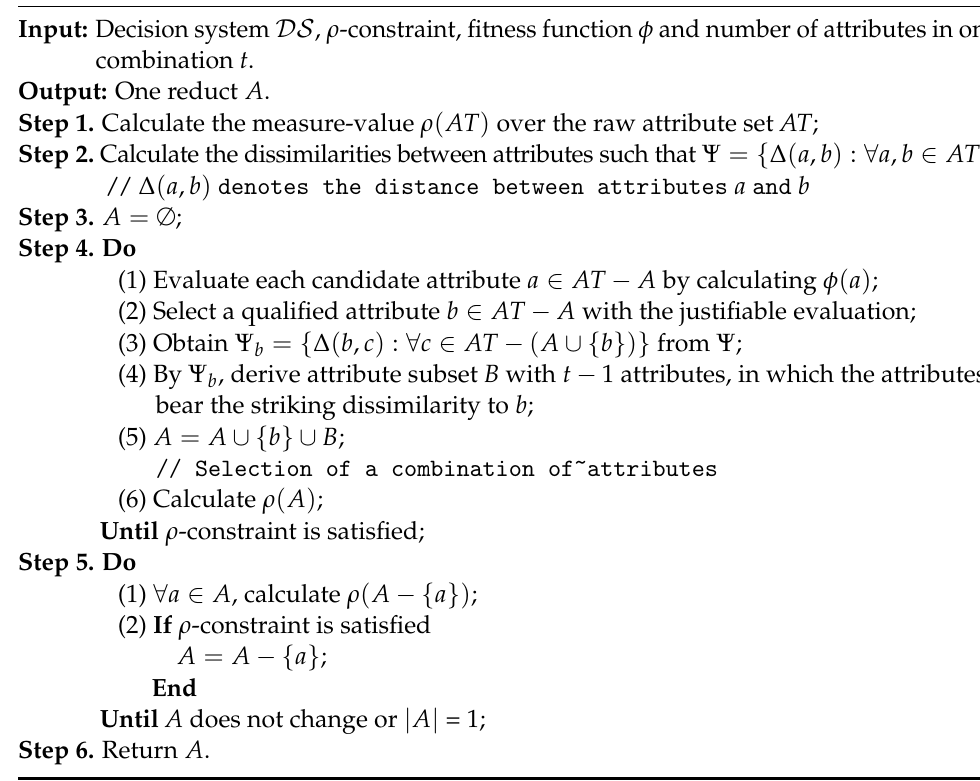
Algorithm 2. Dissimilarity for Attribute Reduction